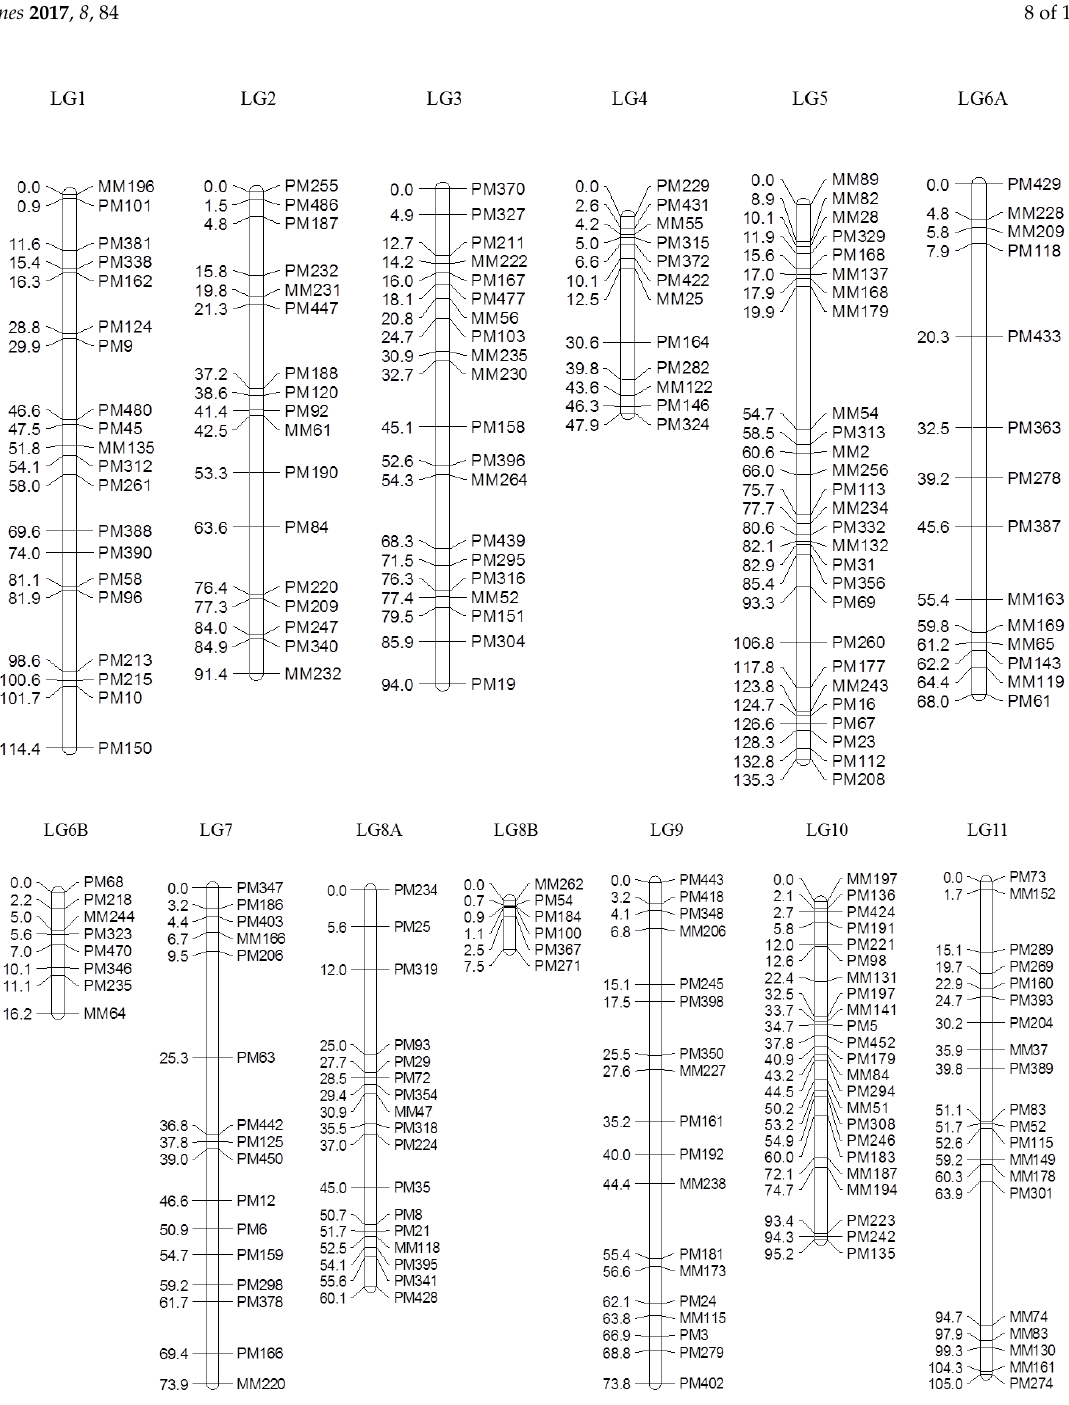
Figure 2. Genetic linkage map of the F 5 segregating population in bambara groundnut constructed using gene expression markers (GEMs). Right: positions of markers (cM); left: name of the markers. LG6 and LG8 were divided into subgroups ‘A’ and ‘B’, respectively, based on the association observed in the MLM due to insufficient linkage to complete the map using regression mapping (RM).